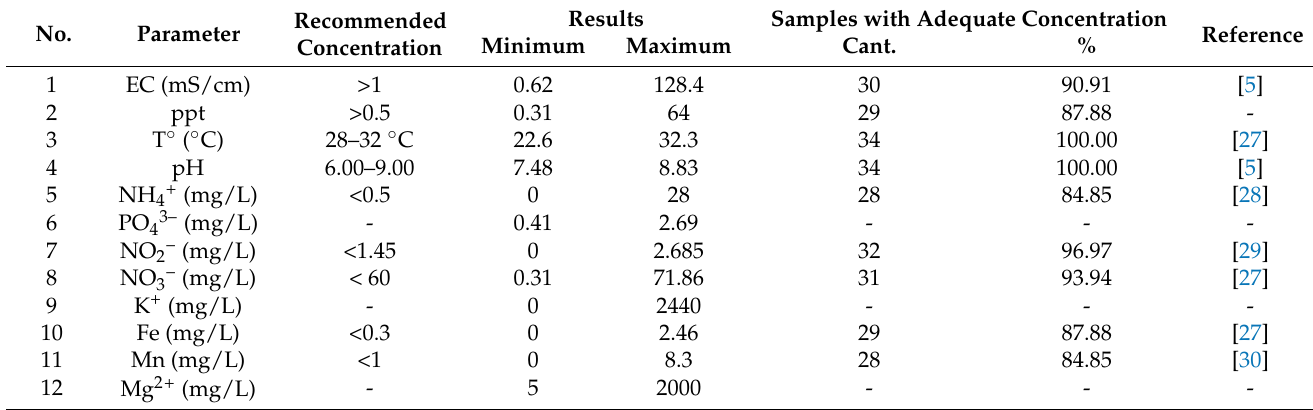
The parameters are: electrical conductivity (EC), pH, total dissolved solids,